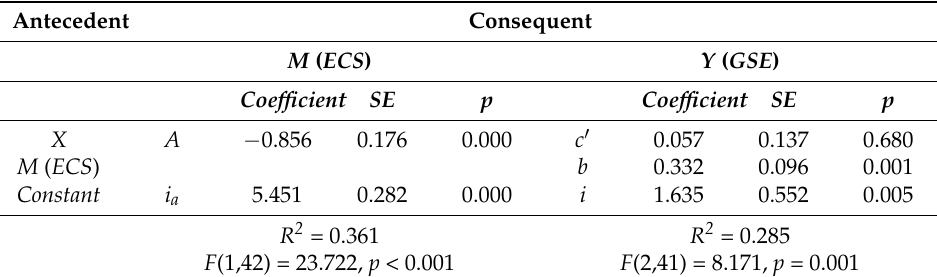
Table 6. Coefficients for the effect of active creation on self-efficacy ( GSE ).